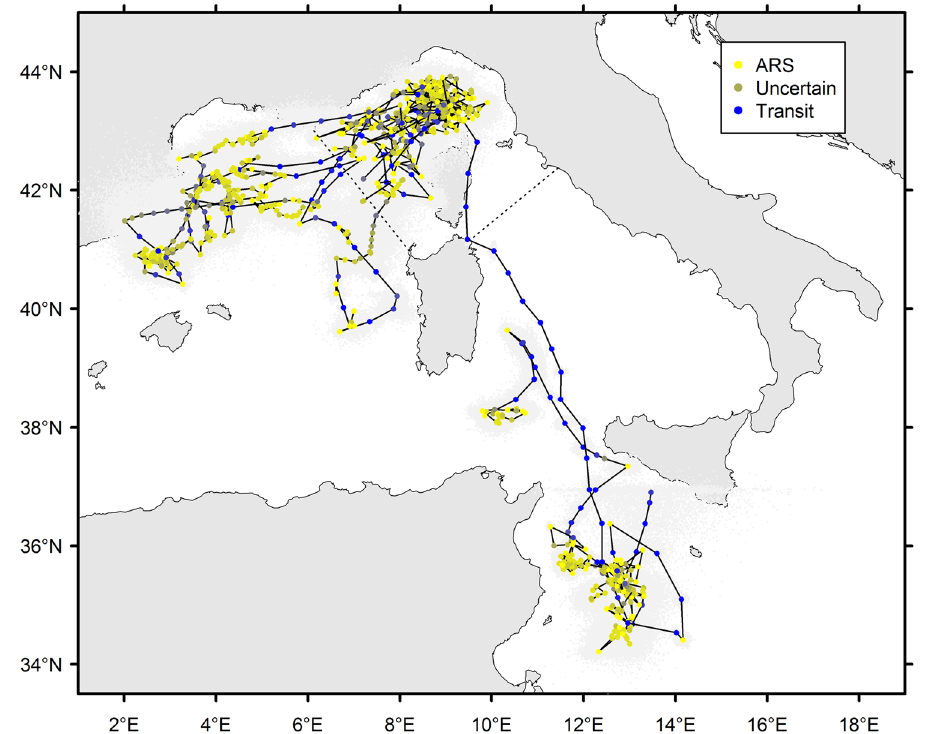
Figure 2. Telemetry tracks of fin whales tagged in the Ligurian Sea in 2012 in the Strait of Sicily in 2013 and 2015, reconstructed from the posterior estimates of the parameters of the hSSSM, and inferred transiting, ARS and uncertain behaviours (based on Jonsen et al .’s 62 conservative cut-off values). The light grey points represent model uncertainty around each location, as indicated by the latitude and longitude values at each MCMC iteration. The map was generated using R software, version 3.2.3 (R Core Team, 2015) with packages PBSmapping (Schnute et al . 2015) and rgdal (Bivand et al . 2016). R Foundation for Statistical Computing, Vienna, Austria